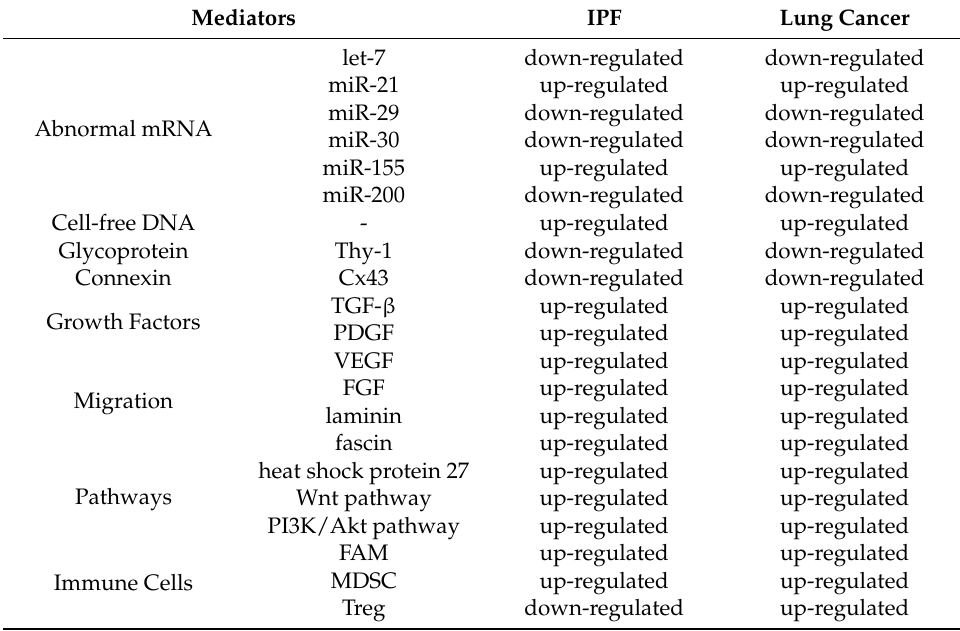
Table 2. Principal factors participating both in lung cancer and idiopathic pulmonary